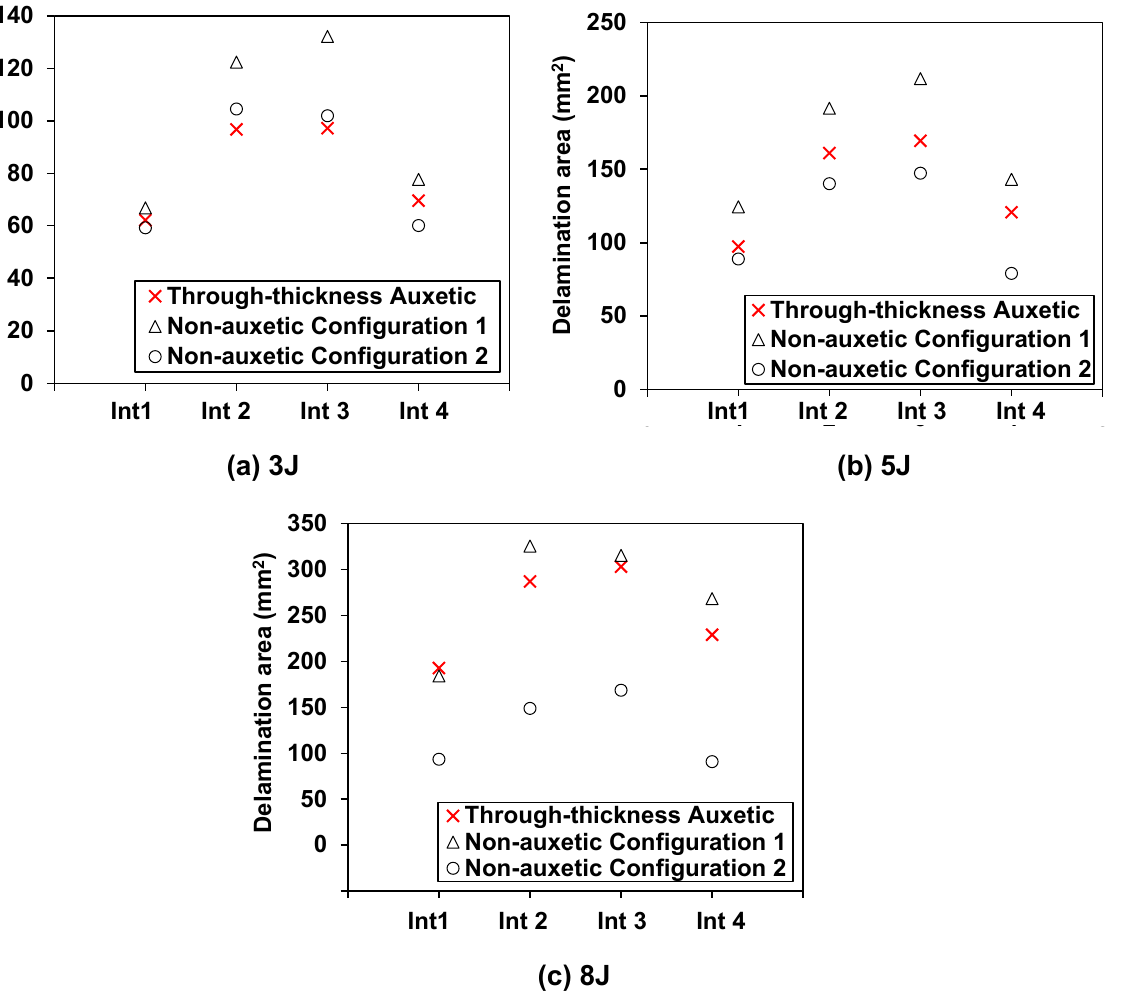
Figure 8. Effect of the through-thickness negative Poisson’s ratio on the delamination: comparison of the predicted delamination area in each interface of the auxetic and corresponding non-auxetic CFRP composite laminates at: ( a ) 3 J, ( b ) 5 J, and ( c ) 8 J, where “int” in the horizontal axis denotes the interface of the composite laminate.